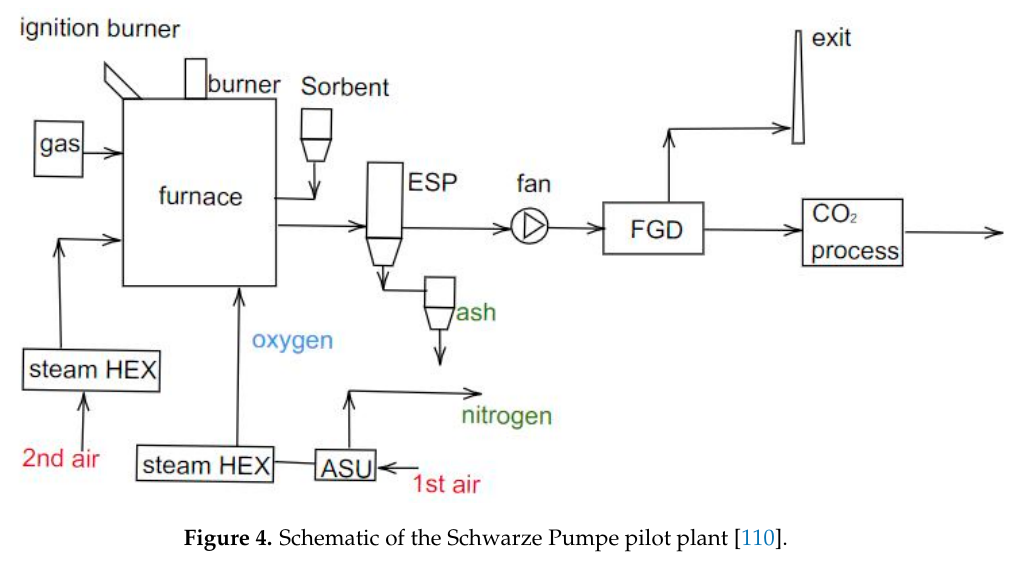
Figure 4. Schematic of the Schwarze Pumpe pilot plant [110].